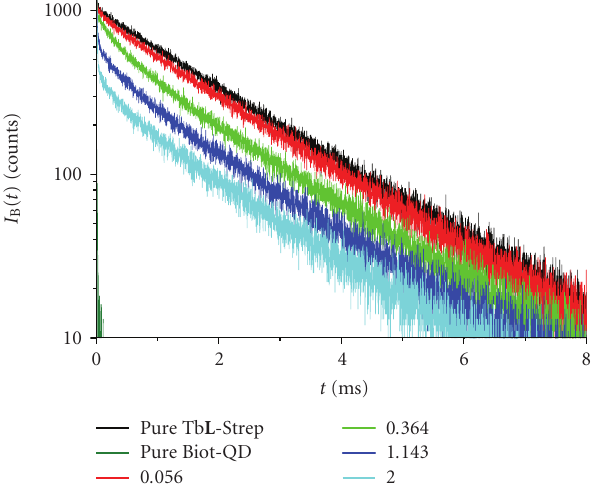
Figure 2: Luminescence and background decay curves (for descrip- tion, see Figure 1) measured in channel B ((545 ±